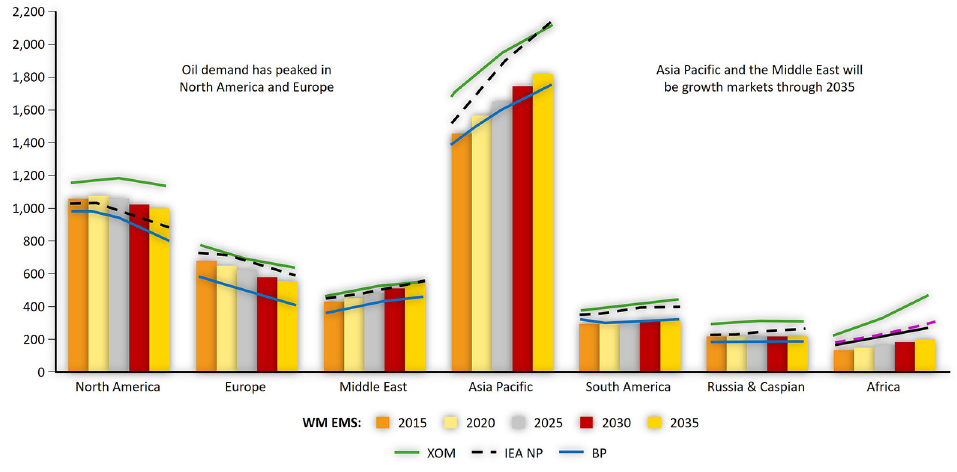
Fig. 13. – World oil demand by region, 2015–2035 (Source: Wood Mackenzie,